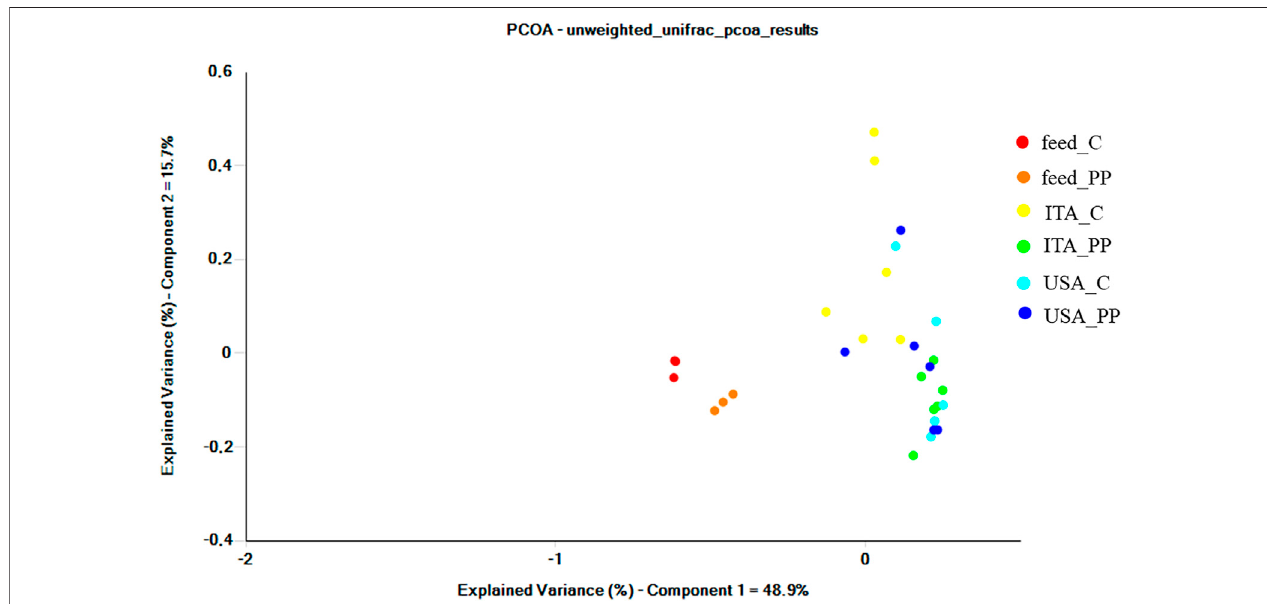
FIGURE3| Betadiversitymetrics.Principalcoordinateanalysis(PCoA)ofunweightedUniFracdistancesofmicrobialcommunitiesassociatedwithgutmucosaand feeds. The fi gure shows the bi-dimensional plot of individual fi sh and feeds samples according to their microbiome pro fi le.